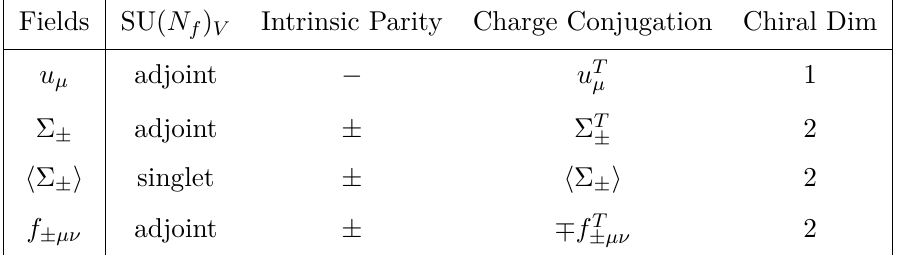
Table 1 . Transformation properties and chiral dimensions of linear building blocks of the chiral Lagrangian (see e.g.